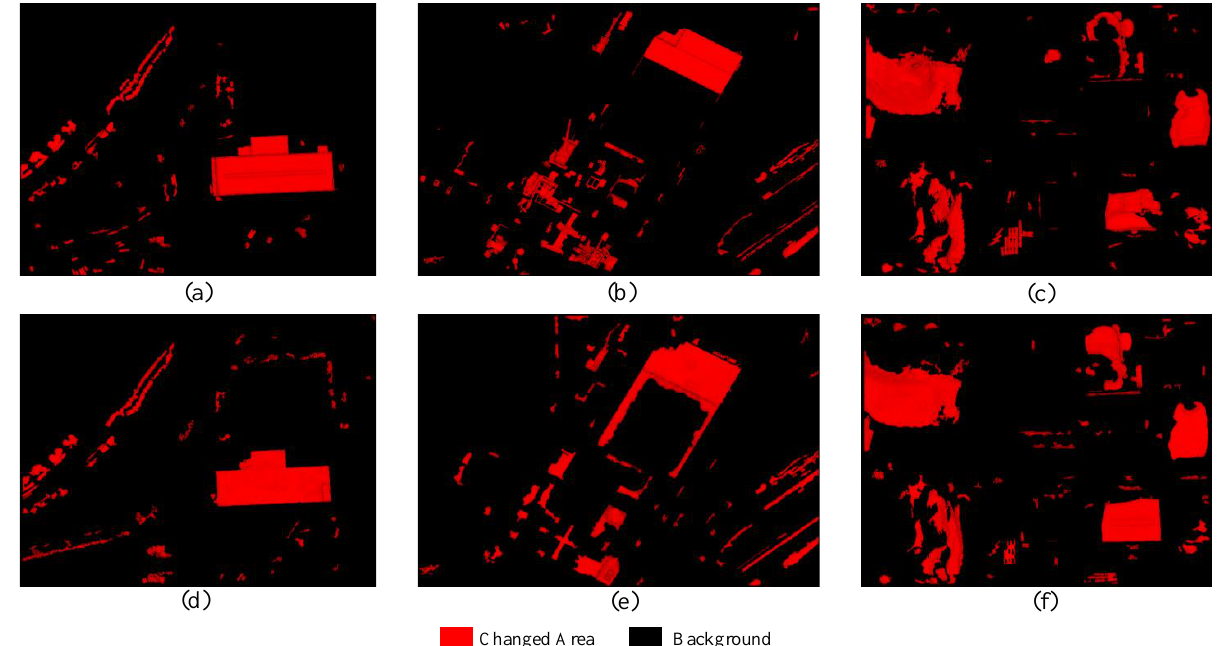
Figure. 6 3D change detection results of traditional Euclidean distance segmentation: (a) is the change detection result if the first phase point clouds of area 1, (d) is the change detection result if the second phase point clouds of area 1, (b) is the change detection result if the first phase point clouds of area 2, (e) is the change detection result if the second phase point clouds of area 2, (c) is the change detection result if the first phase point clouds of area 3, (f) is the change detection result if the second phase point clouds of area 3.